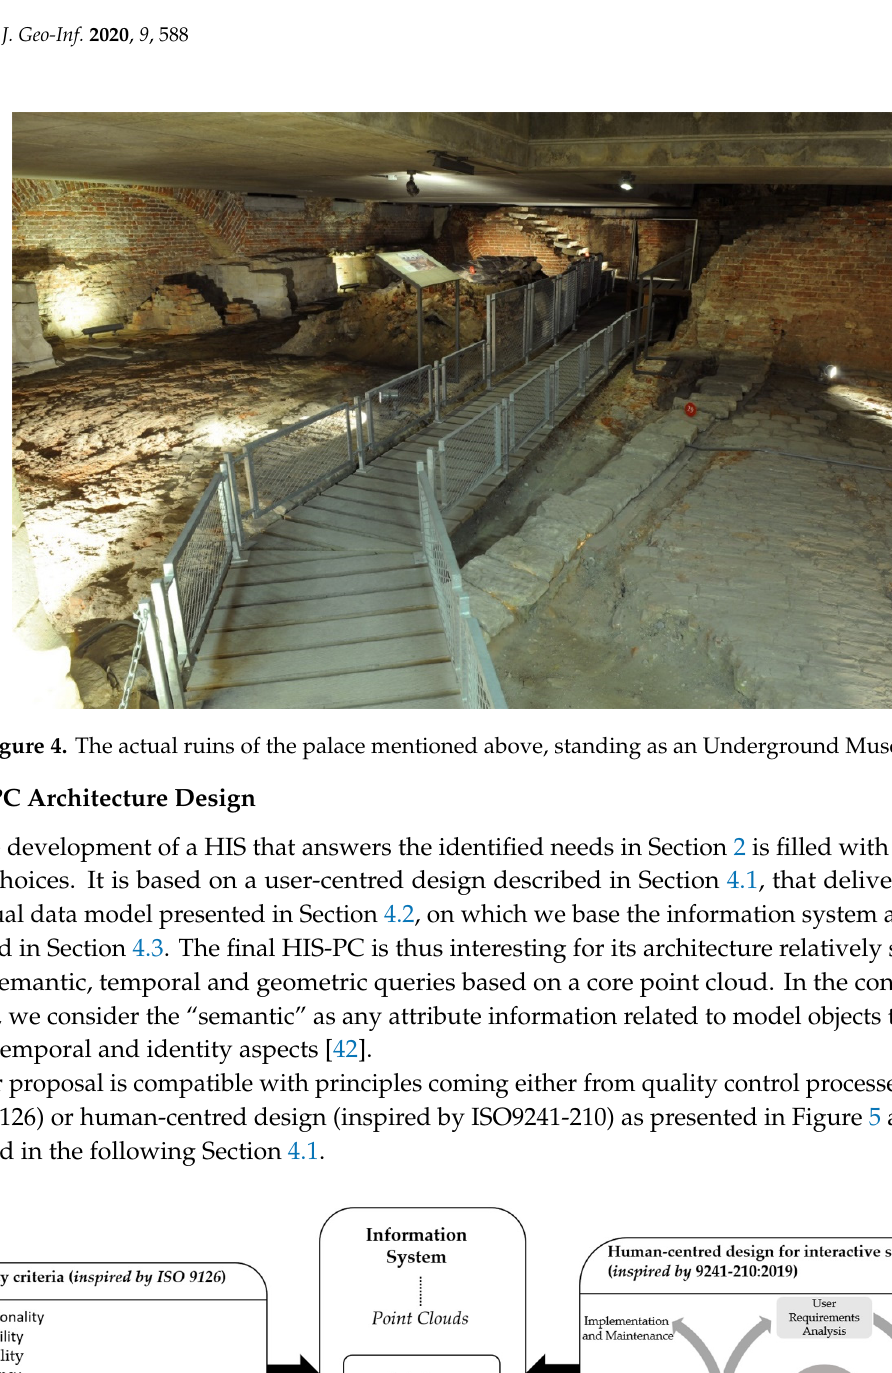
Figure 5. Methodological approach of user ‐ centred and quality information system design.